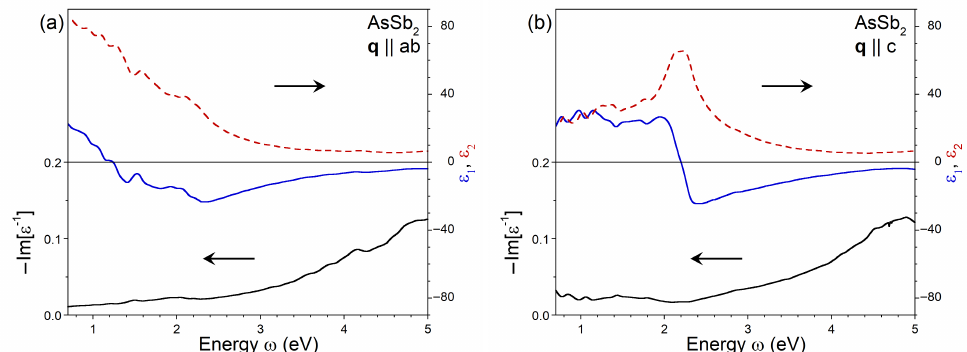
Figure 5. Imaginary (red dashed line) and real (blue solid line) parts of dielectric function in As 0.33 Sb 0.67 calculated at q pointing in ( a ) ab plane and ( b ) c direction obtained with inclusion of the local-field effects and the ALDA kernel. The respective loss function, − Im [ (cid:101) − 1 ] , is shown by black solid